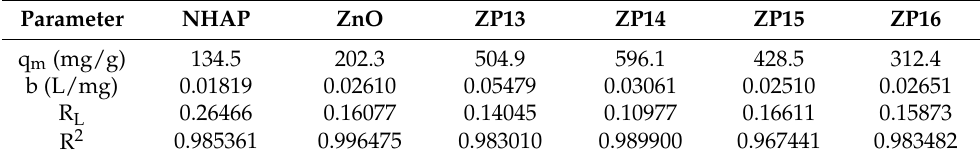
Table 2. Langmuir adsorption parameters for MB adsorption onto prepared solid